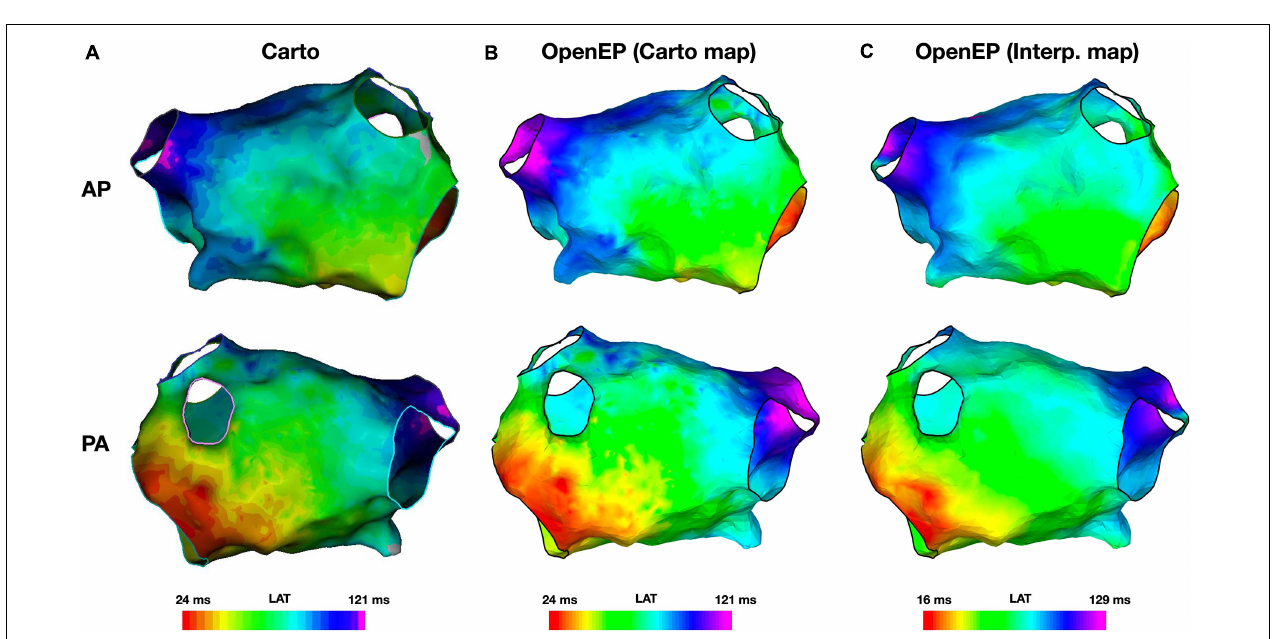
FIGURE 4 | Miscellaneous OpenEP functions. (A) Identification of anatomical structures using the OpenEP command: getAnatomicalStructures(userdata, 'plot', true) . (B) Identification of point status for points referenced in userdata using [inoutpts, meshrefpts] = pointStatus(userdata, 'plot', true) .